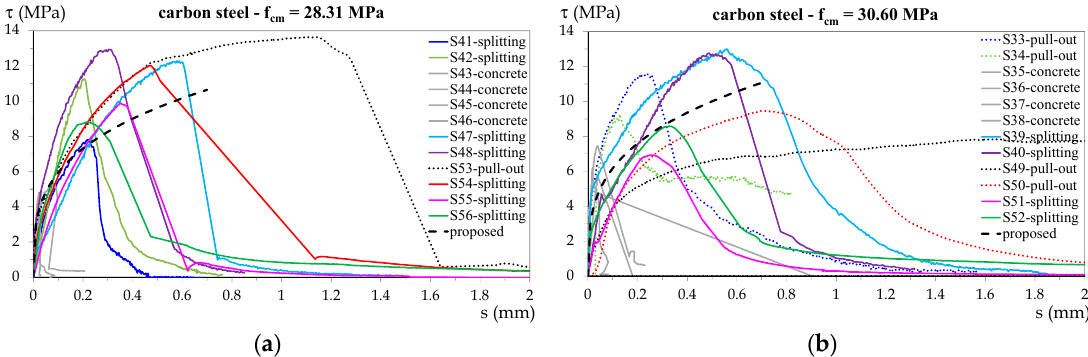
Figure 12. Bond stress–slip diagrams for specimens with carbon steel bars and ( a ) f cm = 28.31 MPa and ( b ) f cm = 30.60 MPa.